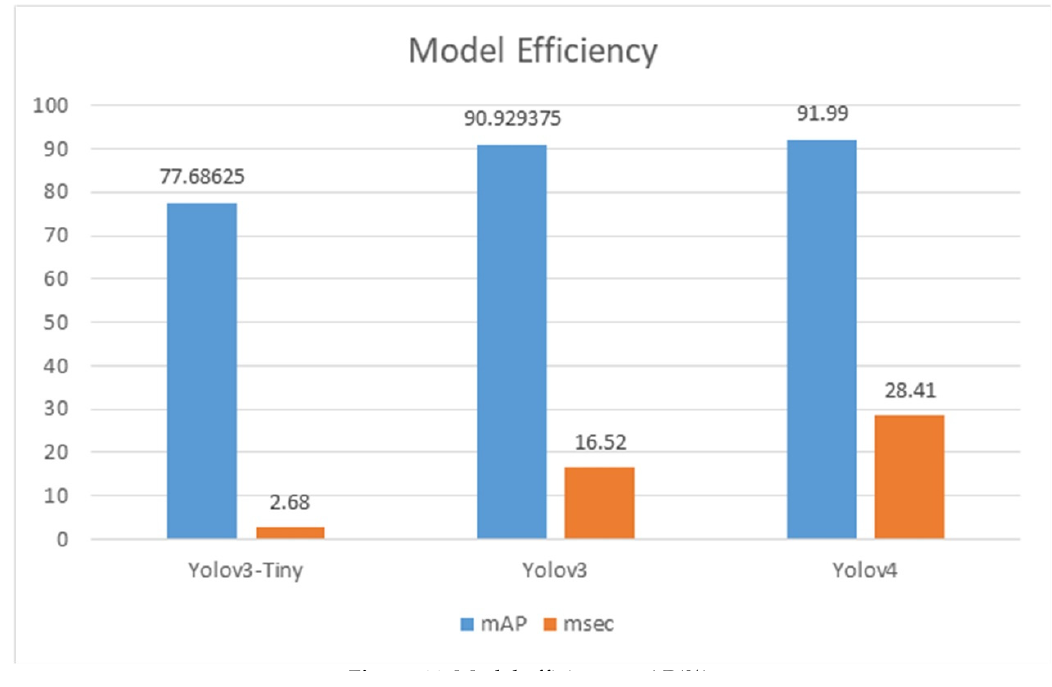
Figure 11. Model efficiency mAP(%). Table 12. Yolov3-Tiny AP/mAP.